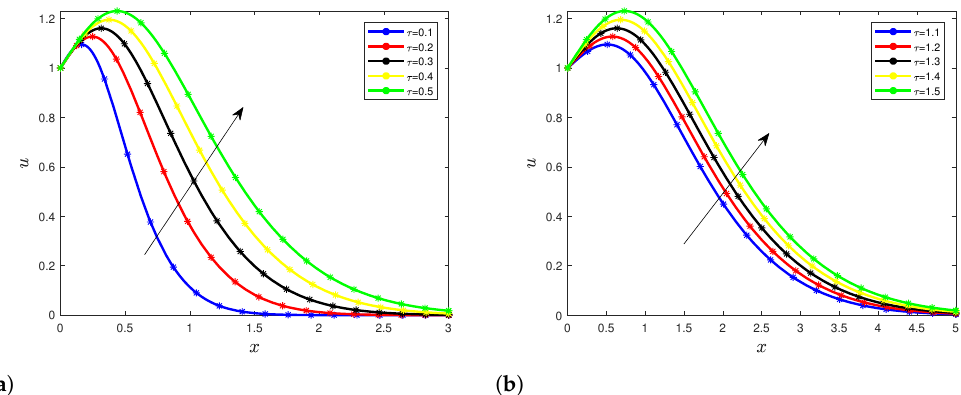
Figure 9. Dynamics of the fractional diffusion reaction equation with various orders with, respectively, τ = 0.5 ( a ) and τ = 1.5 ( b